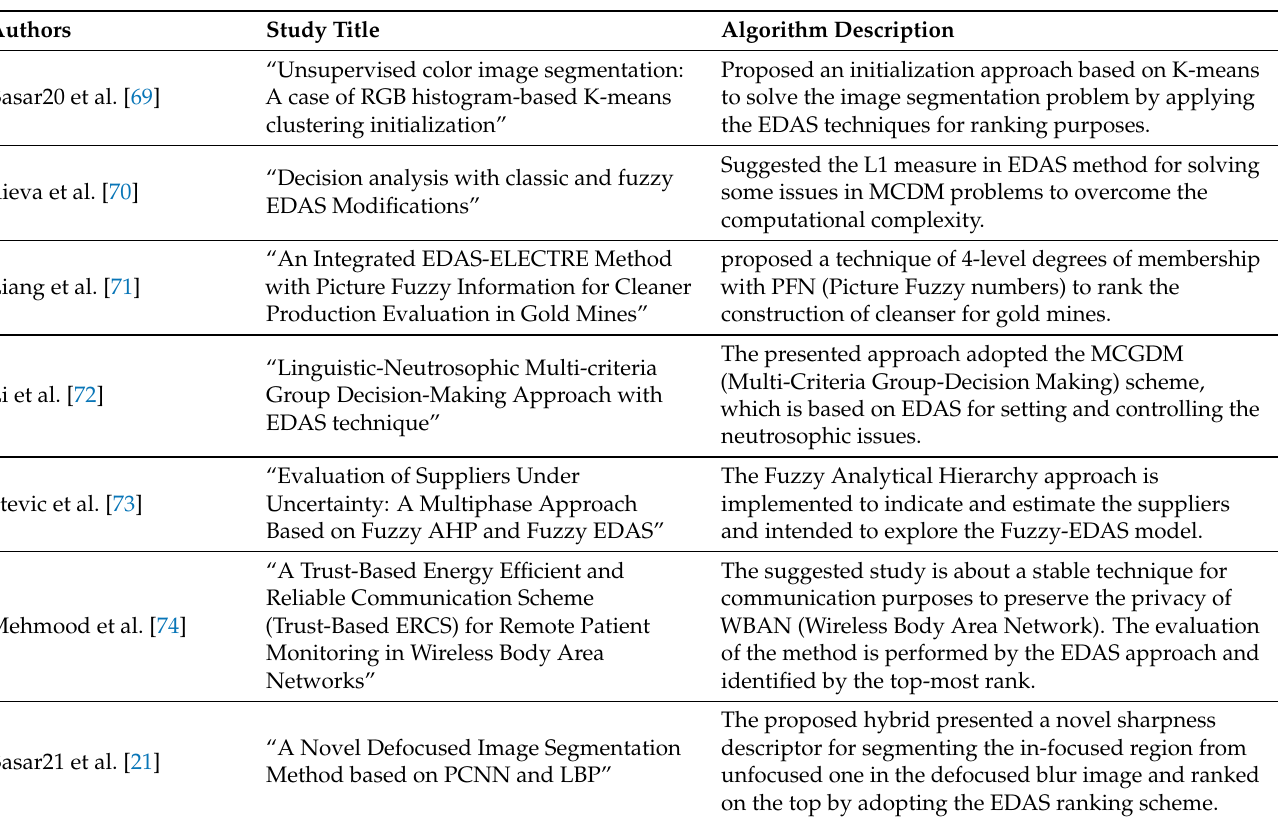
Table 1. Fuzzy logic’s contributions in related research